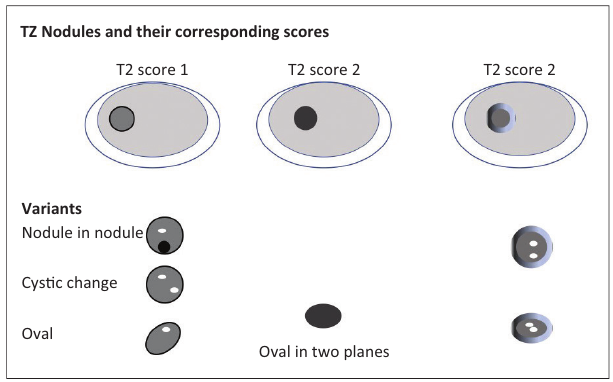
TZ Nodules and their corresponding scores